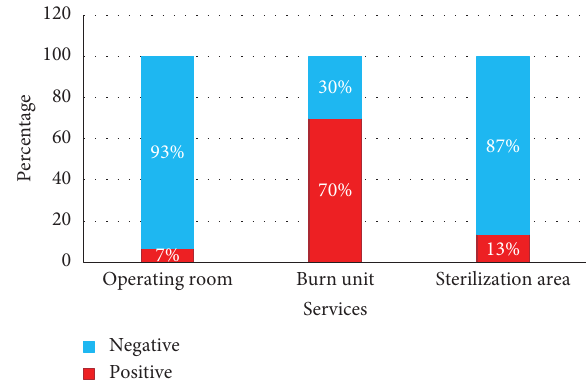
Figure 1: Percentage of contamination by services.